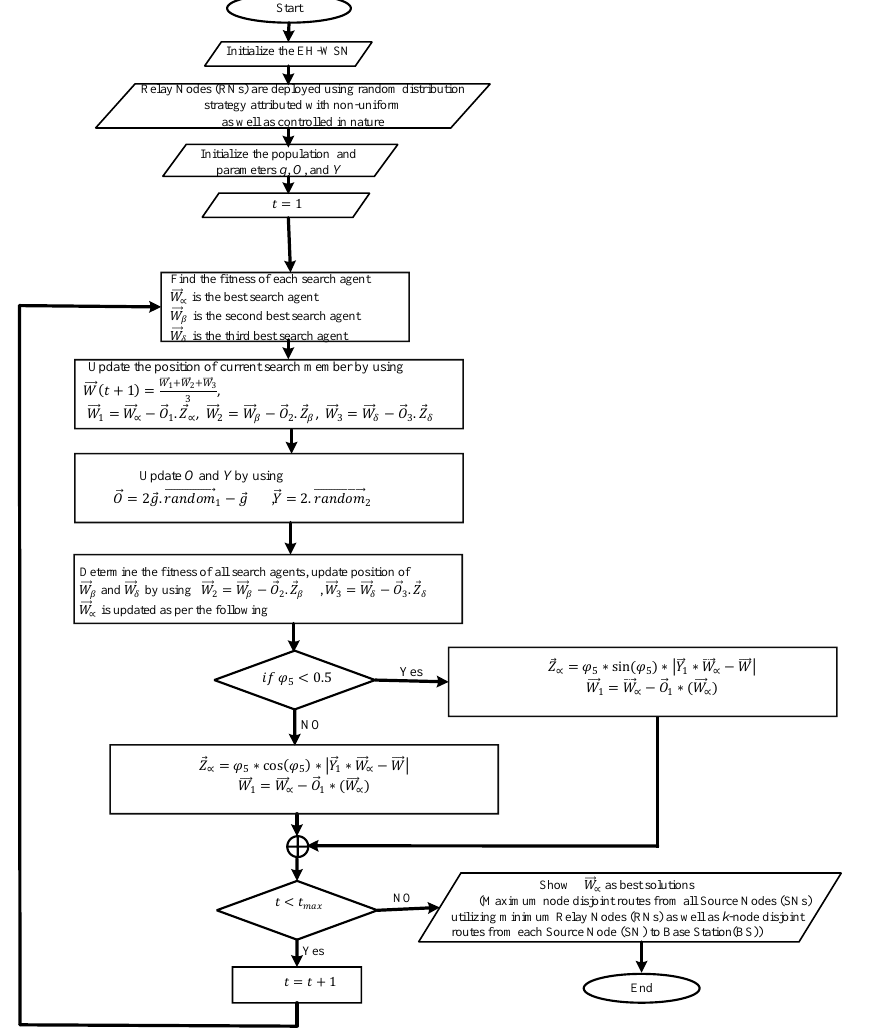
Figure 2. Phase 1 of the proposed framework consisting of the hybrid adapted grey wolf sine cosine optimizer (HA-GWSCO) framework.